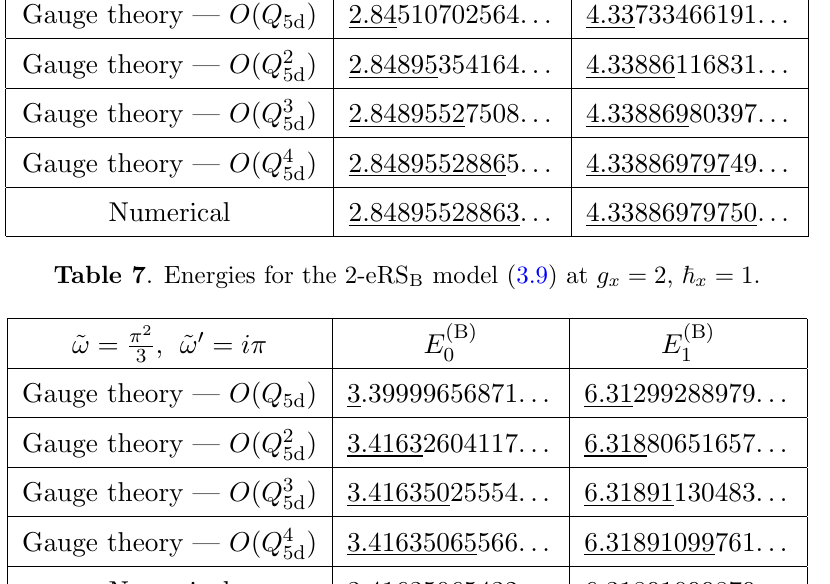
Table 8 . Energies for the 2-eRS B model (3.9) at g x =